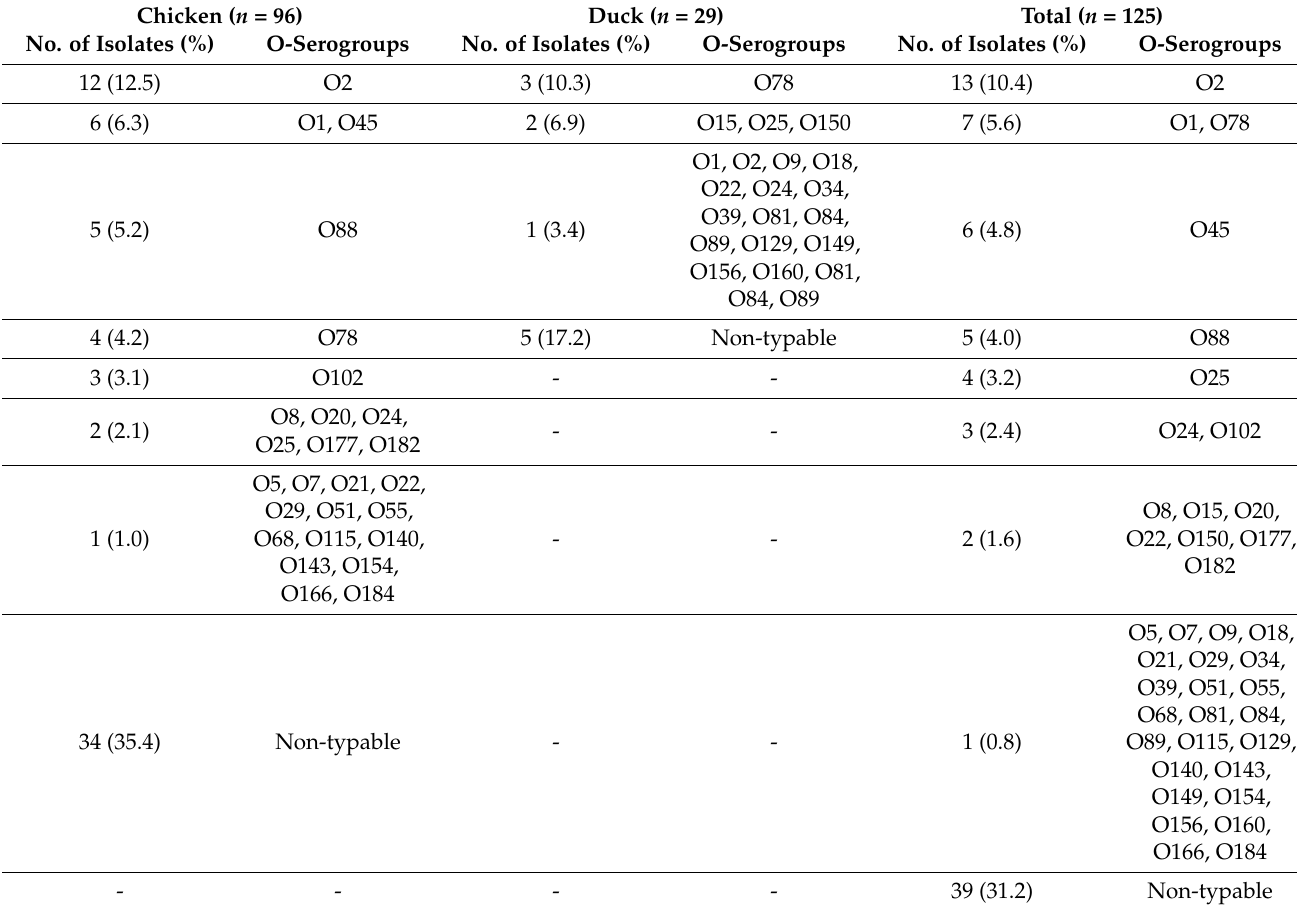
Table 1. O-serogroups of APEC isolates from chickens and